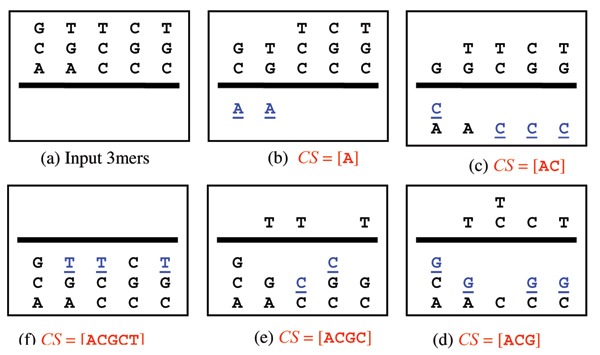
A step-by-step illustration of the process of finding a common supersequence via deposition. The characters above bar represents the sequences have yet to be deposited. The underlined blue characters are the characters that are deposited in the current step. The final result is CS = "ACGCT", which, for this example, is also the optimal result.